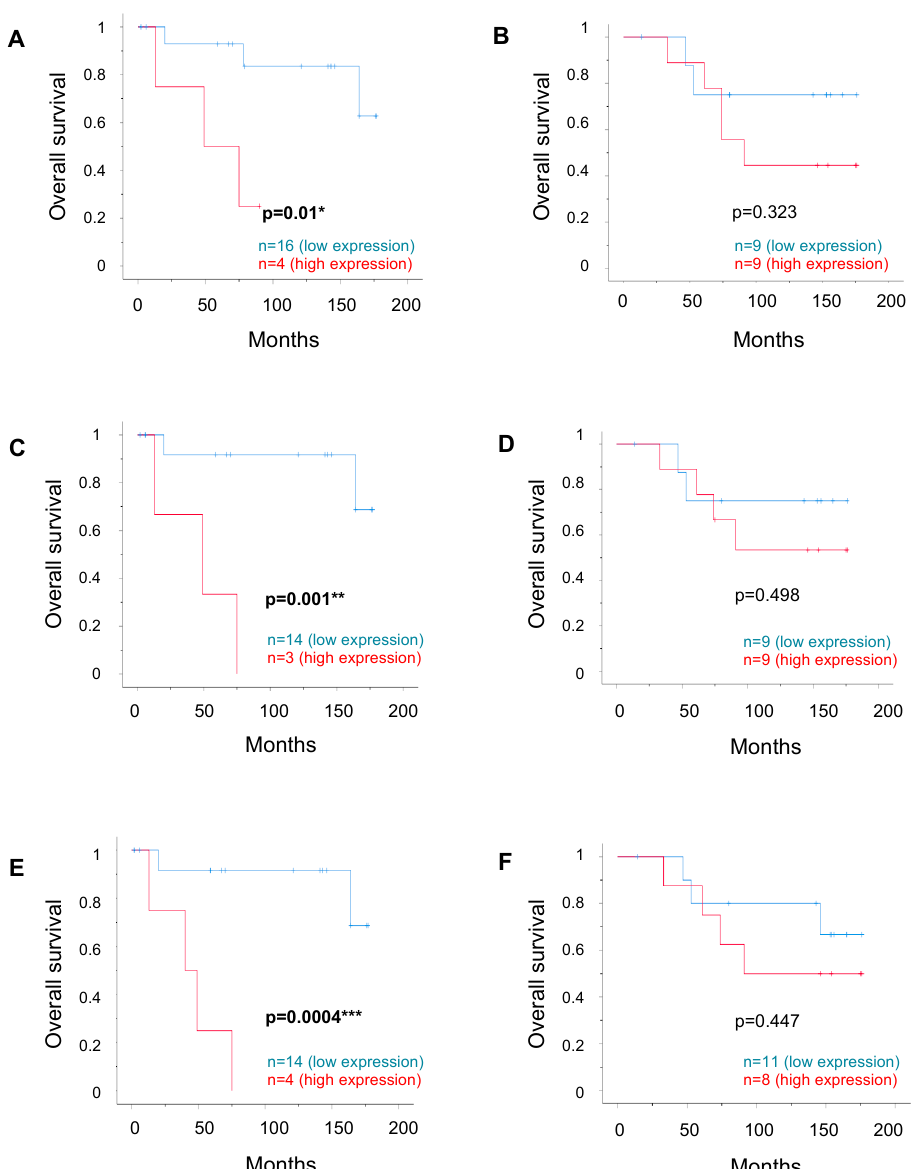
Figure 3. Overall survival according to combined expression of RIP140, LCoR, or ER β . Kaplan–Meier analysis of the correlation between combined low vs. high expression of two markers with OS in the matched pairs (unifocal for A , C , E or multifocal for B , D , F ). The analysis was performed with LCoR expression combined with RIP140 ( A , B ) or ER β ( C , D ) expression, or with RIP140 expression combined with ER β expression (E, F). Correlations are statistically significant for p < 0.05 (*), for p < 0.01 (**), and for p < 0.001 (***).